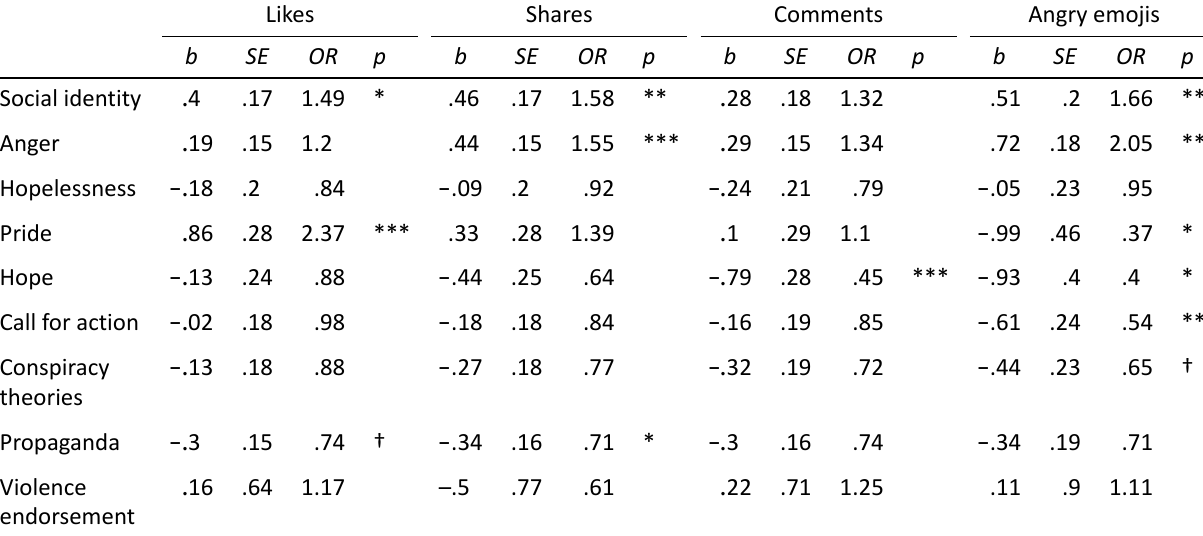
Table 6. Regression analyses for popularity indicators.